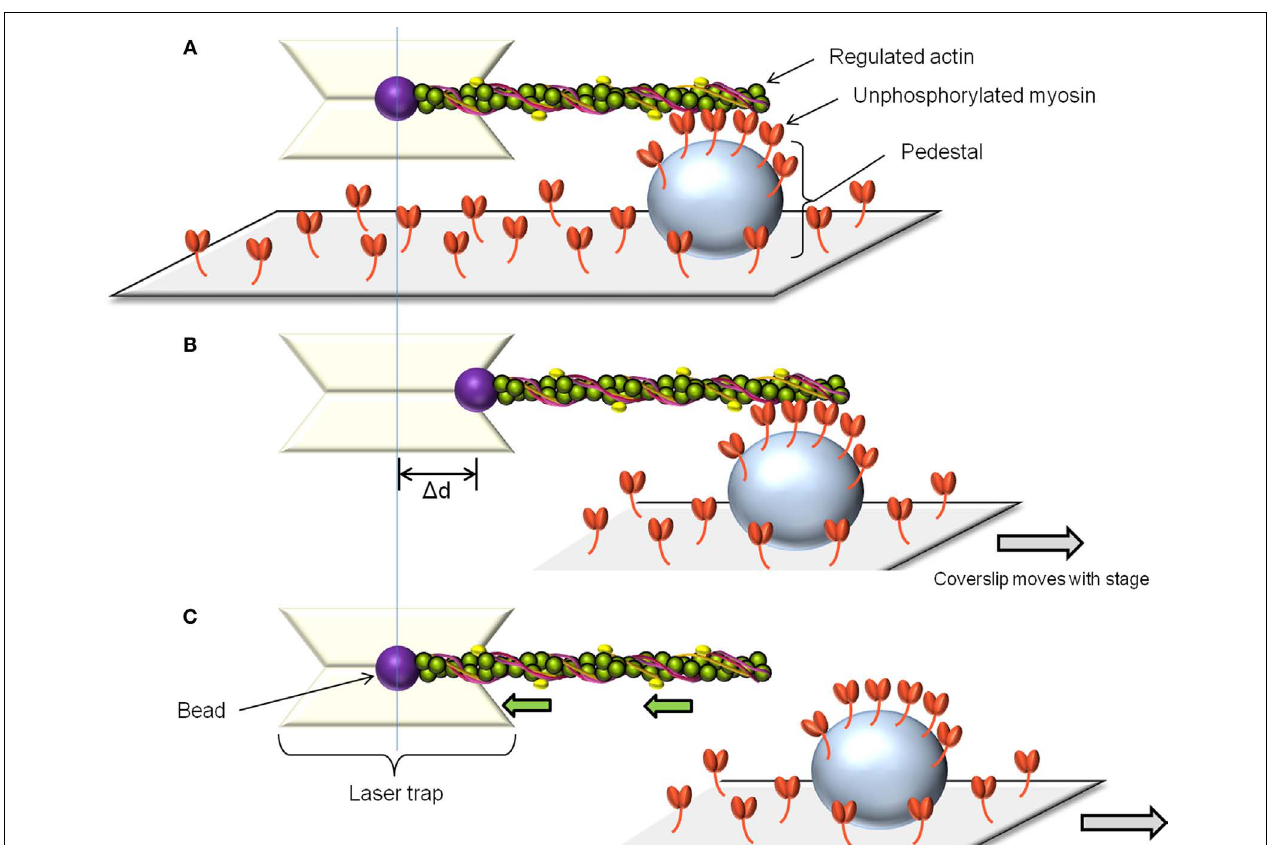
pedestal is moved away from the laser trap at constant speed (B) . Initially, the bead remains offset from the trap center.When the pulling force exerted by the trap exceeds the binding force of the unphosphorylated myosin molecules, the bead springs back into the trap center, its unloaded position. (C) The unbinding force is the product of the maximal distance between the bead and the trap center ( Δ d ) by the trap stiffness.This force can be normalized by the number of myosin molecules estimated to interact with the actin